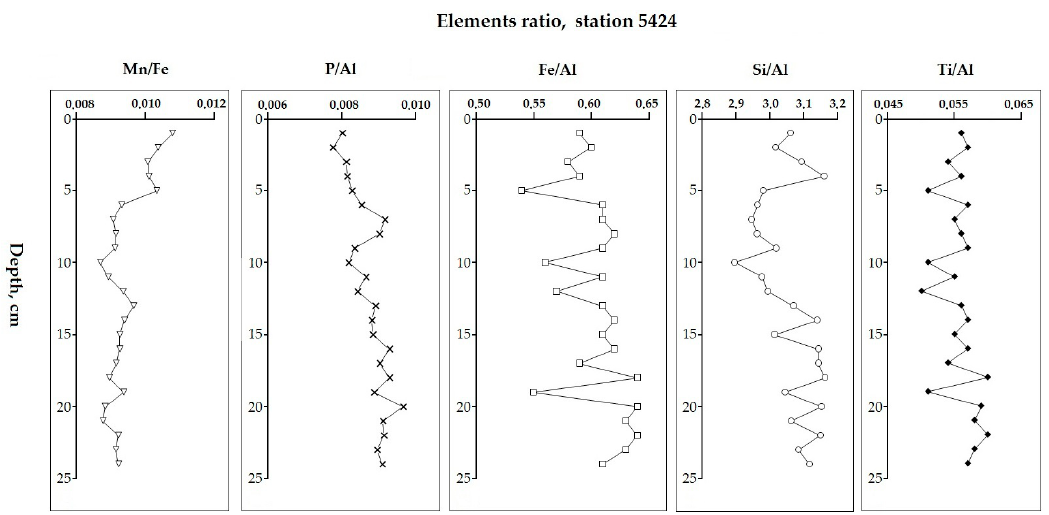
Figure 10. The elemental ratios down the core AMK-5424, the Russkaya Gavan’ Bay, Novaya Zemlya Archipelago. Dotted line means element ratio's average for the core.